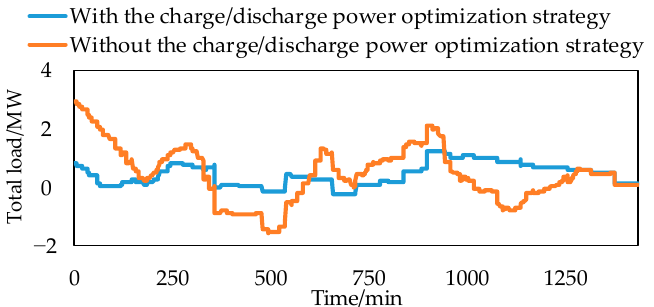
Figure 8. Comparison of load curve with and without charge/discharge power optimization strat- egy.